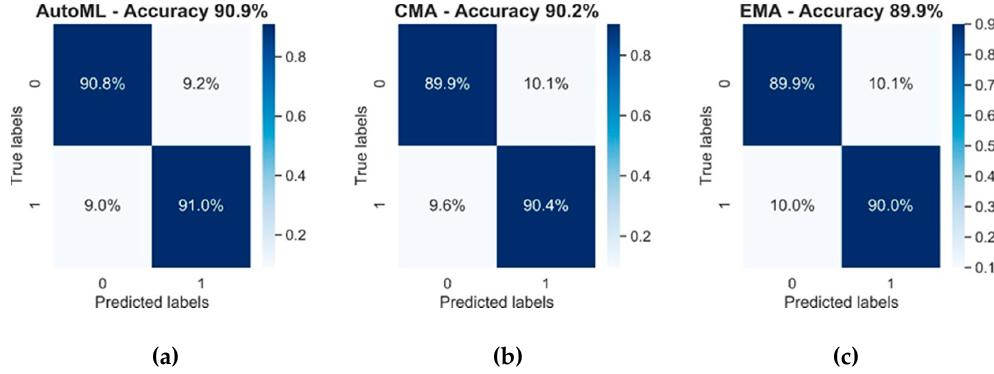
Figure 2. Confusion matrices and accuracies of the 3 models on the test dataset. The labels indicate predicted and actual vehicle availability. AutoML, automated machine learning ( a ); CMA, cumulative moving average ( b ); EMA, exponential moving average ( c ).